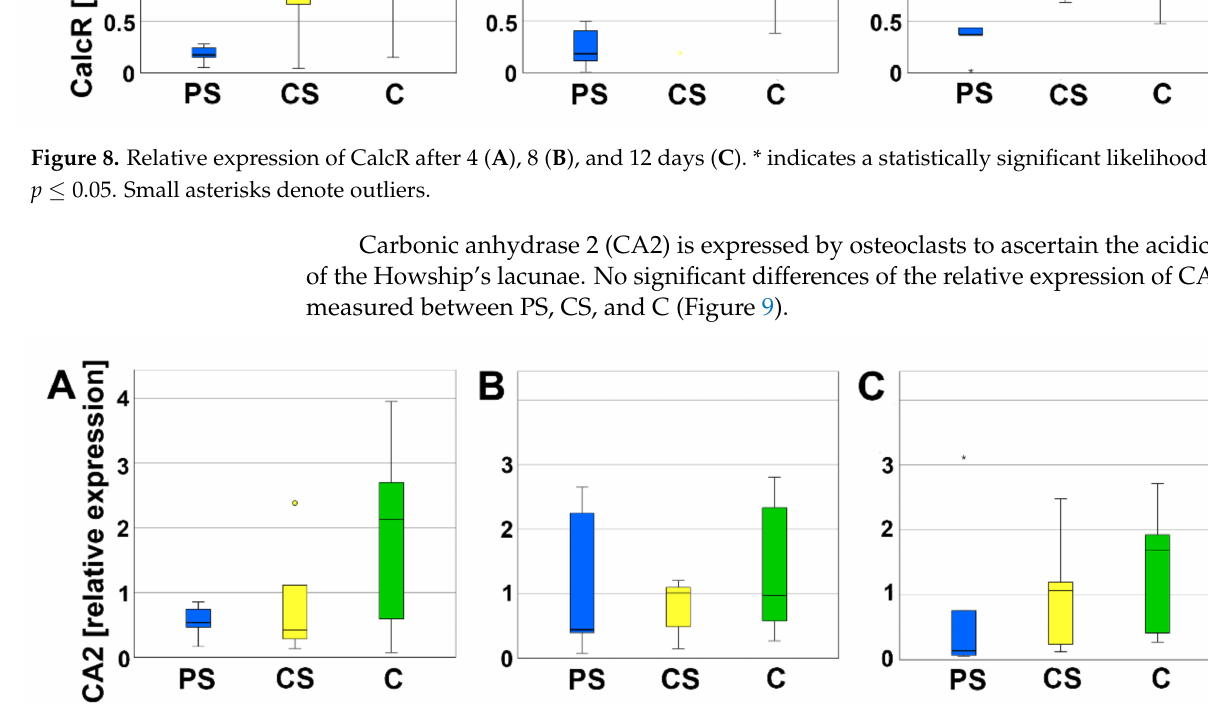
Figure 9. Relative expression of CA2 after 4 ( A ), 8 ( B ), and 12 days ( C ). Circles and small asterisks denote